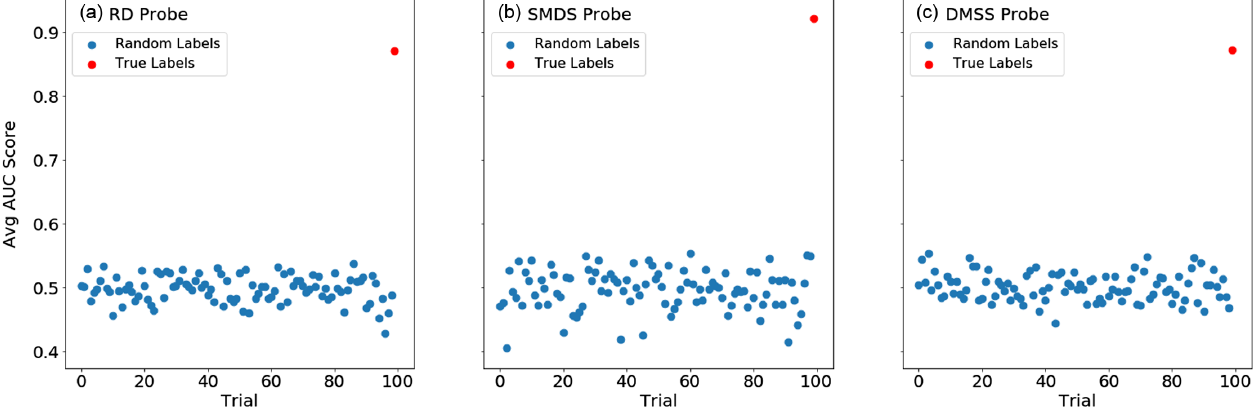
FIG. 5. Average AUC for 100 random trials and 1 true trial. For each probe, this graphic shows, in blue, the AUC (averaged over all three categories) produced when we randomize the input labels to the logistic regression model. The red data point is the average AUC when the correct labels are used on the training data, showing significant improvement and true pattern recognition.